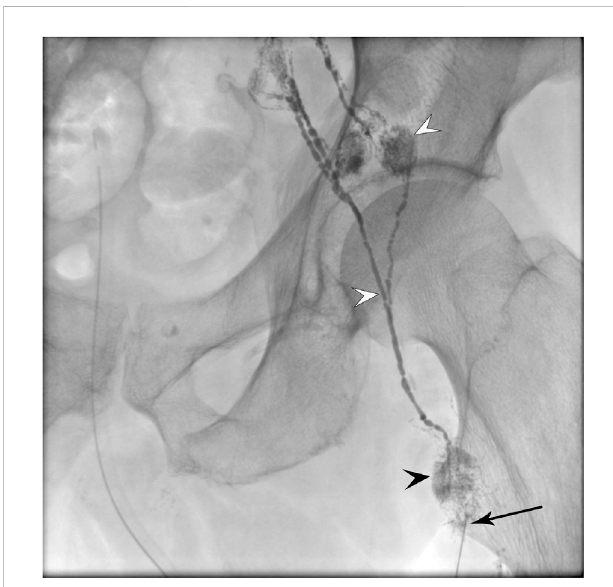
FIGURE 3 The fl uoroscopic image of the intranodal lymphangiography that is performed by placing a needle (arrow) inside the inguinal lymph node (black arrowhead) and injecting oil based iodinated contrast. The efferent lymphatics and distal lymph nodes (white arrowheads) are opaci fi